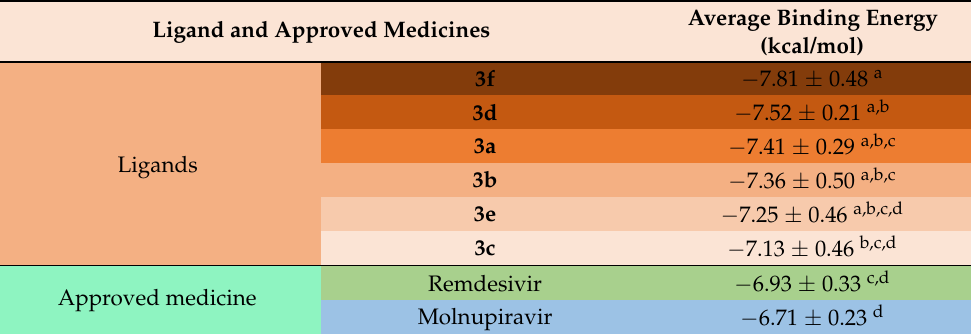
Table 2. Means and SDs of the binding affinities of the nine docking poses for compounds against the COVID-19 main protease 7BQY.